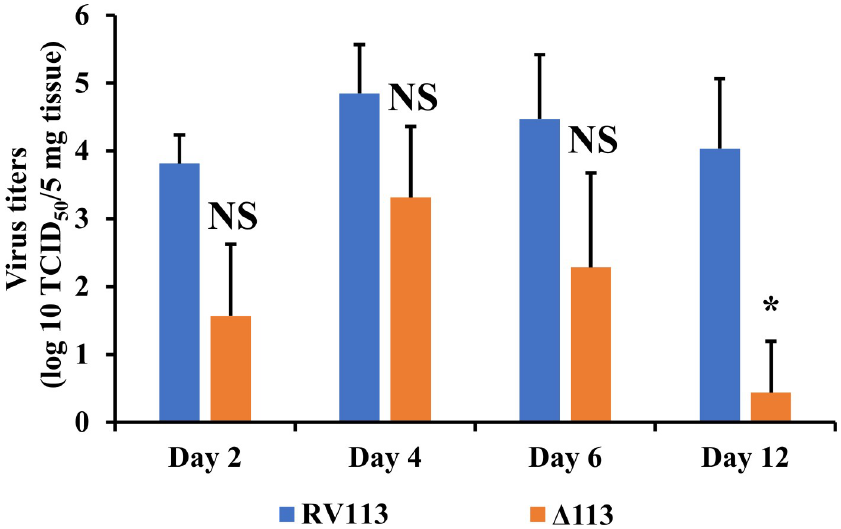
Fig 10. Effect of ORFV113 on viral titers of ORFV-infected animals. Skin biopsies were collected from animals infected with viruses OV-IA82 Δ 113 GFP ( Δ 113) or OV-IA82RV113 HA (RV113), or mock infected at various times p.i. Titers were determined as described in material and methods, and expressed as TCID 50 /5mg tissue. Error bars represent mean ± SD. Statistical analysis was performed using paired Student’s t-test ( � , P < 0 . 05 , NS : non-significant ).